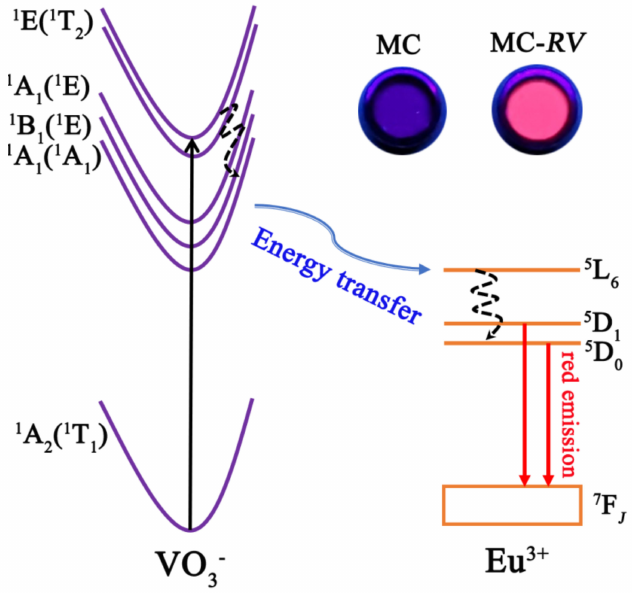
Figure 10. Schematic illustration of VO 3 − → Eu 3+ energy transfer.